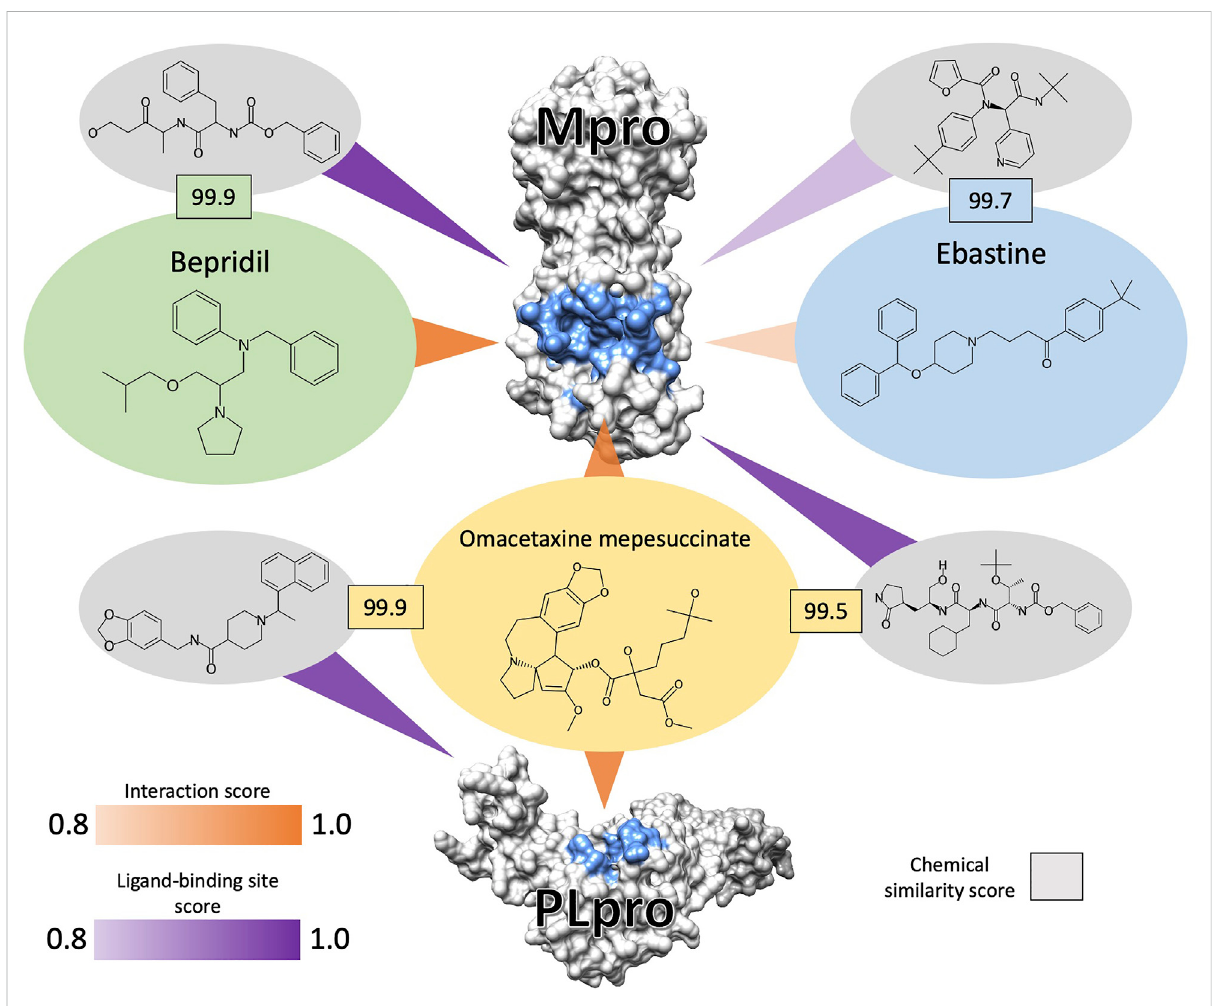
FIGURE 4 Analysis of selected interactions between SARS-CoV-2 proteases and top ranked CANDO-generated drug candidates. The main (Mpro, top) and the papain-like (PLpro, bottom) proteases are depicted in grey with the binding site residues colored blue. Bepridil (green) and omacetaxine mepesuccinate(orange)rankedat15and1inthe3.5.20 denovo list,andebastine(blue)rankedat92inthe5.18.20similaritylist,areshownbound to oneor bothproteases. Theseconstitute example interactionsofwhen CANDO madeasuccessfulprediction as well asillustrate why candidate generation is not perfect from a mechanistic multiscale perspective. The interaction score (orange triangles) between the compounds and the proteases were generated using the bioanalytic docking protocol BANDOCK, with higher scores (maximum 1.0) predicting a higher likelihood of interaction. The ligand associated with the bindingsite predictions bythe COACHalgorithm and chosen as thetemplate for BANDOCK are depicted in grey ellipses (full names available in the Supplementary Material), all of which are strong coronavirus protease inhibitors. These ligands are compared to the query drug using the ECFP10 chemical fi ngerprint via RDKit and a similarity score is assessed based on the Sorenson-Dice coef fi cient. The percentile of the similarity (black outlined boxes) from the corresponding distribution of all similarities between the query compounds and all ligands in the binding site library is multiplied by the con fi dence score associated with the binding site prediction from COACH (purple triangles) to serve as the fi nal score. Bepridil inhibits the full SARS-CoV-2 virus and Mpro in vitro with EC50s of 0.86 and 72 μ M, which was successfullyassignedastronginteractionscoreof0.98.Ontheotherhand,ebastinealsoinhibitsthefullvirusandMprowithEC50sof0.5and57 μ M, yet was assigned a lower interaction score of 0.82. Despite the strong percentile similarity score between ebastine and its template ligand (99.7), the con fi dence score for thisbindingsite prediction was 0.82, signi fi cantly lowering the fi nal interaction score. However, ebastine is the3rd mostsimilar compoundtonel fi navir,aknownhumanimmunode fi ciencyvirusproteaseinhibitorwithactivityagainstSARS-CoV-2,basedoninteractionsimilarity to a library of 5,317 human proteins, suggesting its putative mechanism as a protease inhibitor. Omacetaxine mepesuccinate, the second strongest fullvirusinhibitorpredictedbyCANDOwithanEC50of0.03 μ M,wasthetopcandidatefromthe denovo listandhasinteractionscoresof0.960and 0.964 with Mpro and PLpro, respectively, and has not yet been validated in terms of target speci fi city. Based on the high interaction scores, we propose this as its mechanism not only for SARS-CoV-2, but for all other coronavirus species against which it has activity. In this manner, the mechanistic understanding of drug candidate behavior is readily deciphered in a multiscale manner, from the atomic-level fi ngerprints between the noveldrugcandidatesandtheinteractingligandstotheevolutionaryinformationembeddedattheproteinandproteomescales,andexempli fi esthe ability of the CANDO platform to accurately identify novel drug candidates and their mechanisms via a multi-pronged